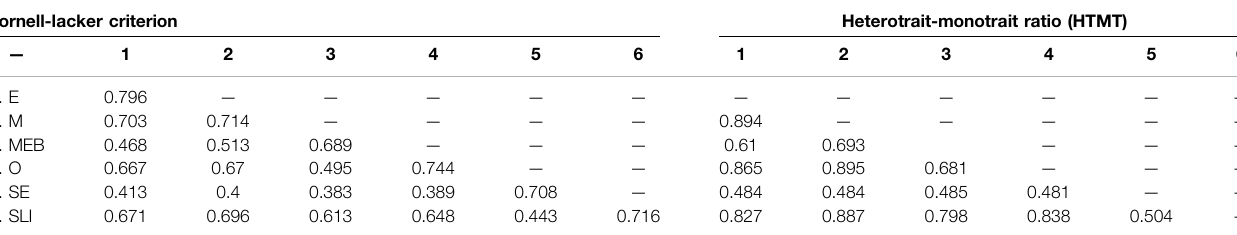
TABLE 3 | Discriminant validity.